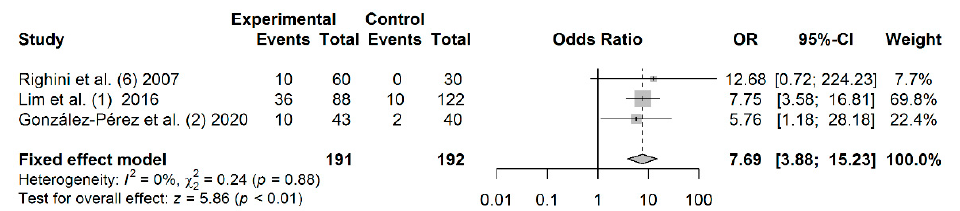
Figure 6. Forest plot for the association between RASSF1A promoter hypermethylation and the HNC risk. The squares represent the ORs for individual studies. Bars represent the 95% CIs. The center of the diamond represents the summary effect size.